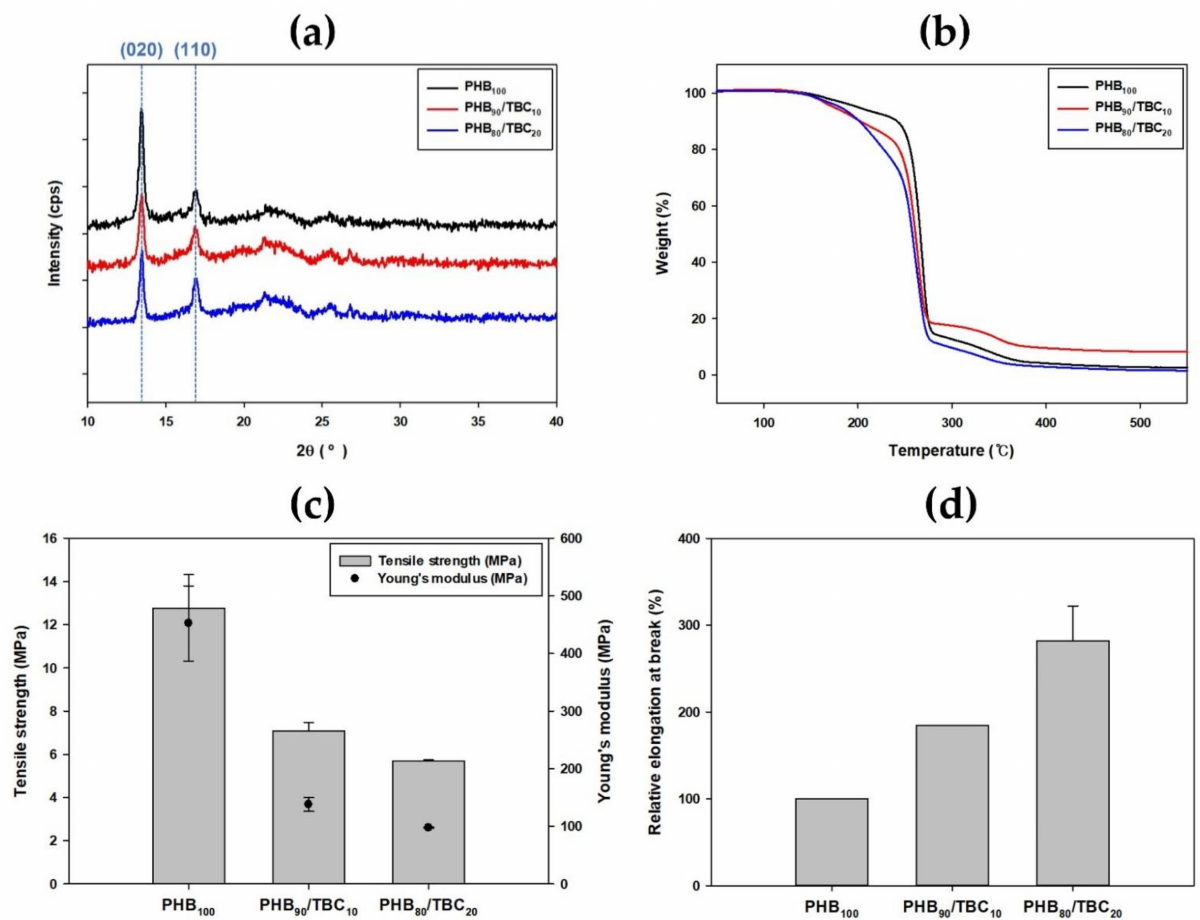
Figure 5. Changes in various properties according to the addition of tributyl citrate. Comparison of ( a ) XRD spectra and ( b ) thermo gravimetric analysis (TGA) result. Mechanical properties change expressed as ( c ) tensile strength (MPa), Young’s modulus (MPa), and ( d ) relative elongation at break (%) measured using a universal testing machine